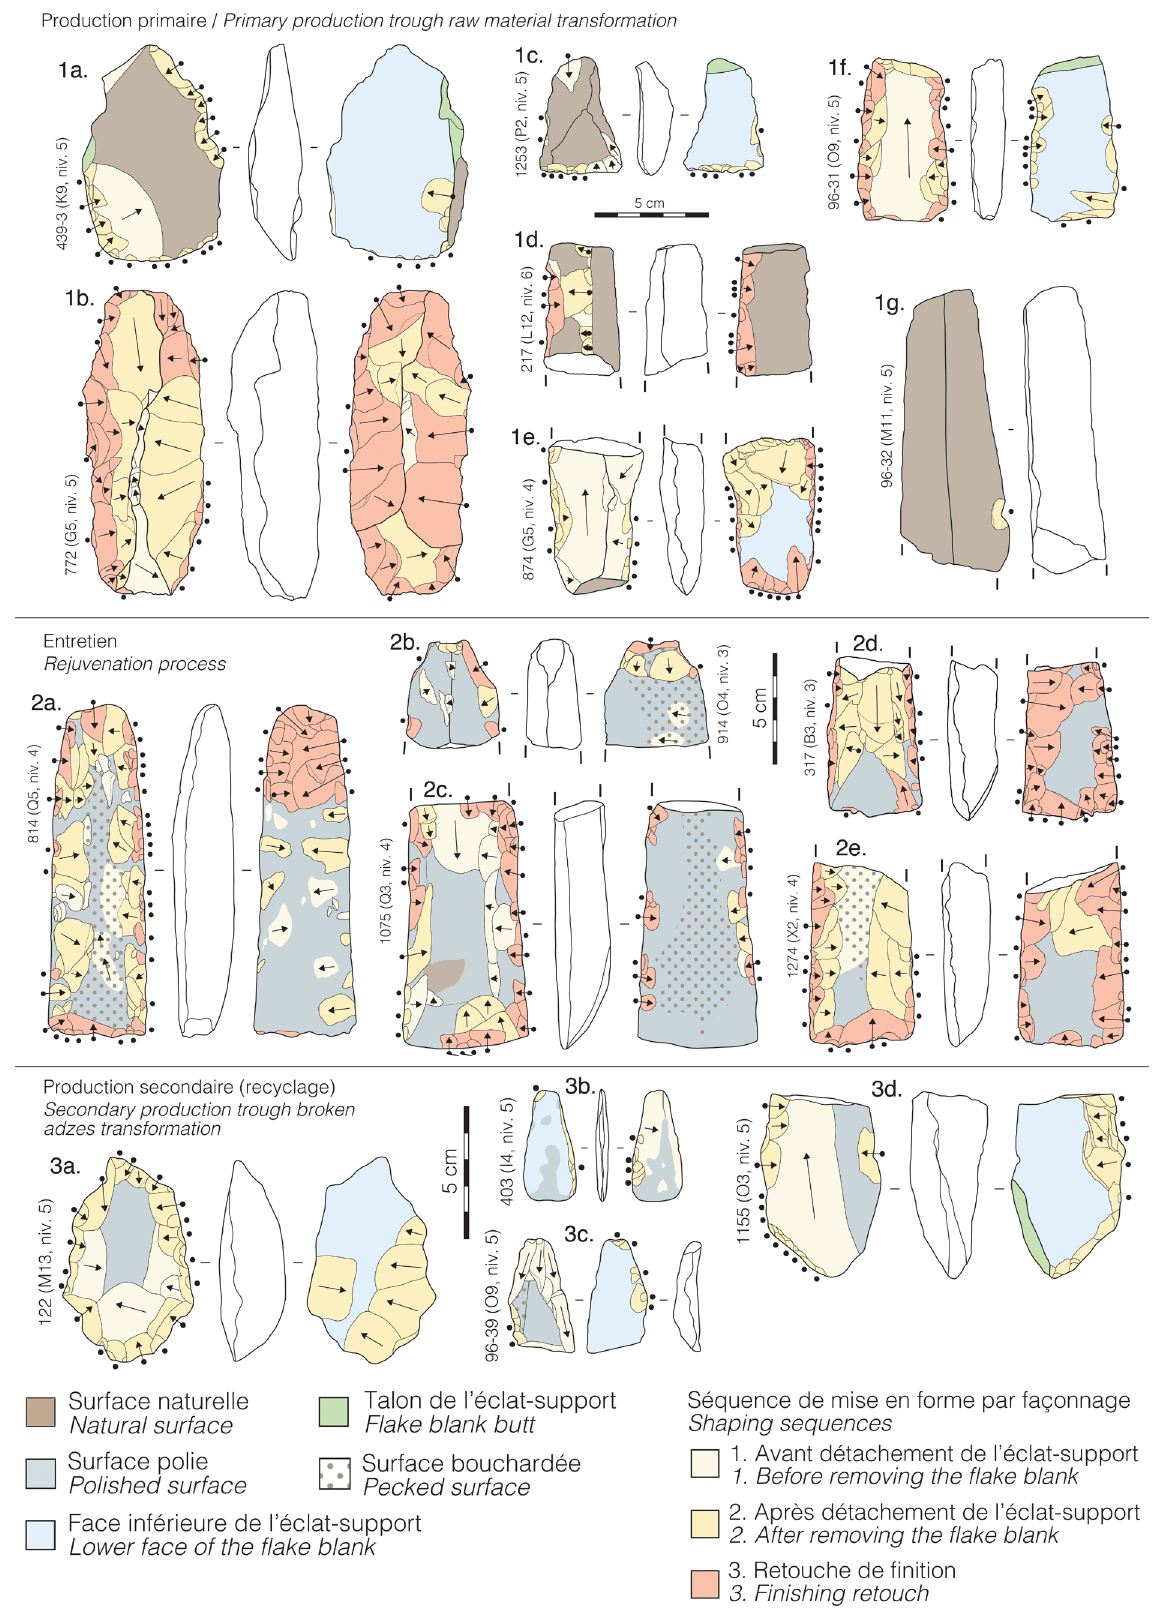
Figure 18. Schéma diacritique des ébauches et préformes de lame à Tanataetea. Figure 18. Diacritical sketch of Atiahara adze roughouts and